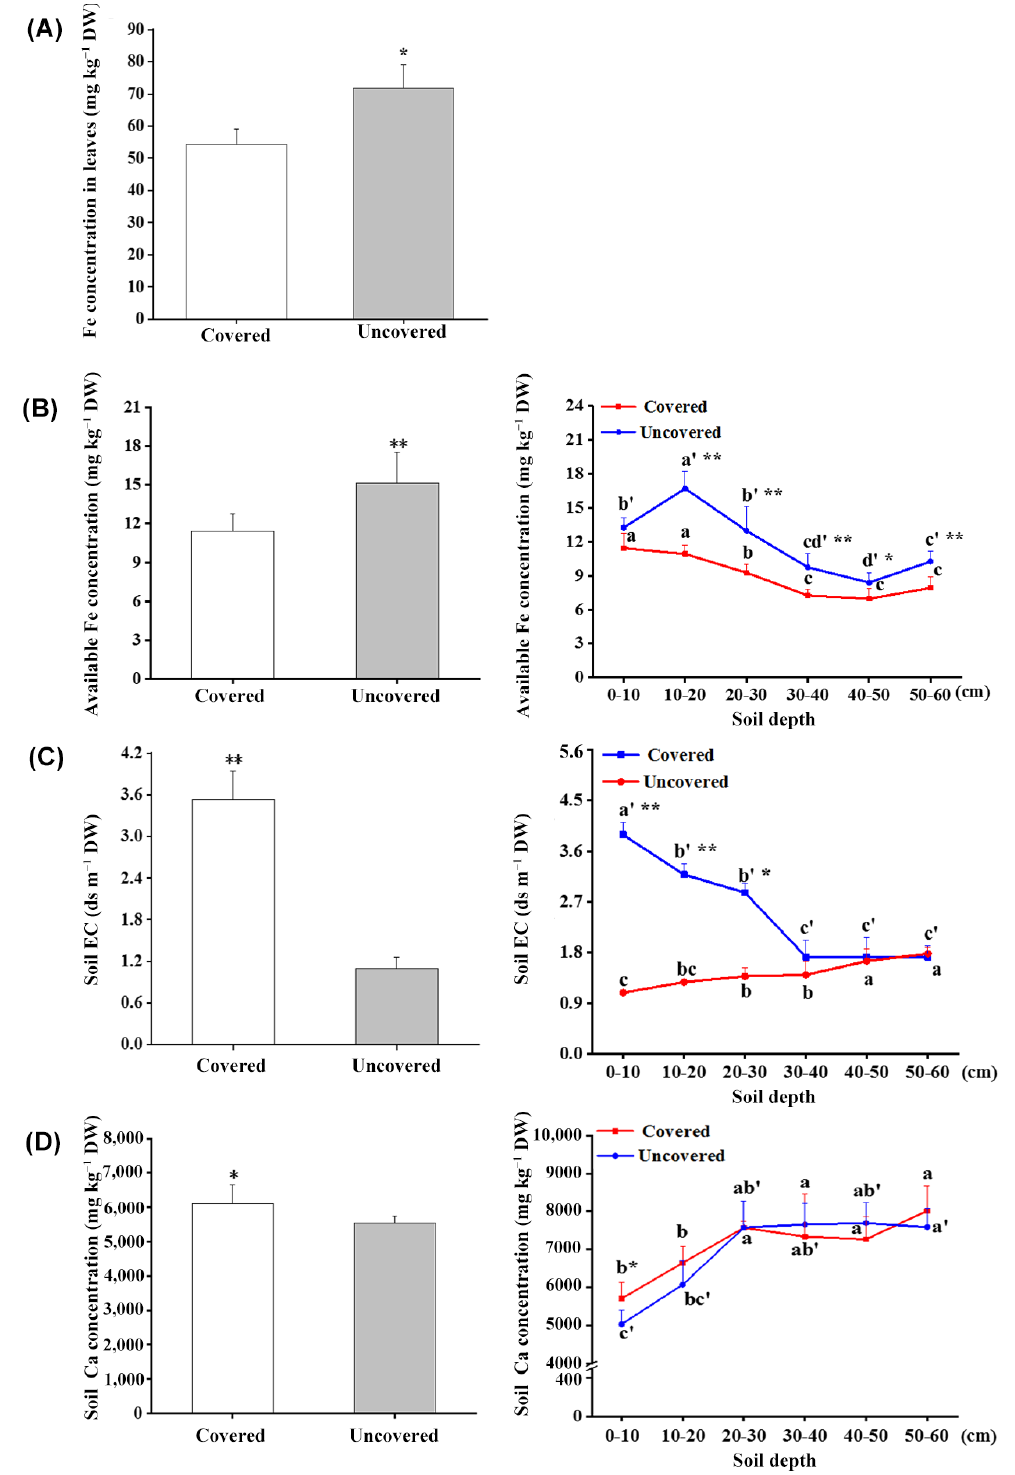
Figure 4. The Fe concentration in leaves ( A ), available Fe concentration in soil ( B ), EC and salt content ( C ), Soil Ca concentration ( D ) in the period of coverture with film and without coverture with film. Asterisks indicate significant difference between coverture and without coverture (* p < 0.05; ** p < 0.01). Small letters indicate significant differences at p < 0.05. Covered: covered with plastic film; Uncovered: uncovered with plastic film. And a, a’ was used for the significant difference of coverture and without coverture,